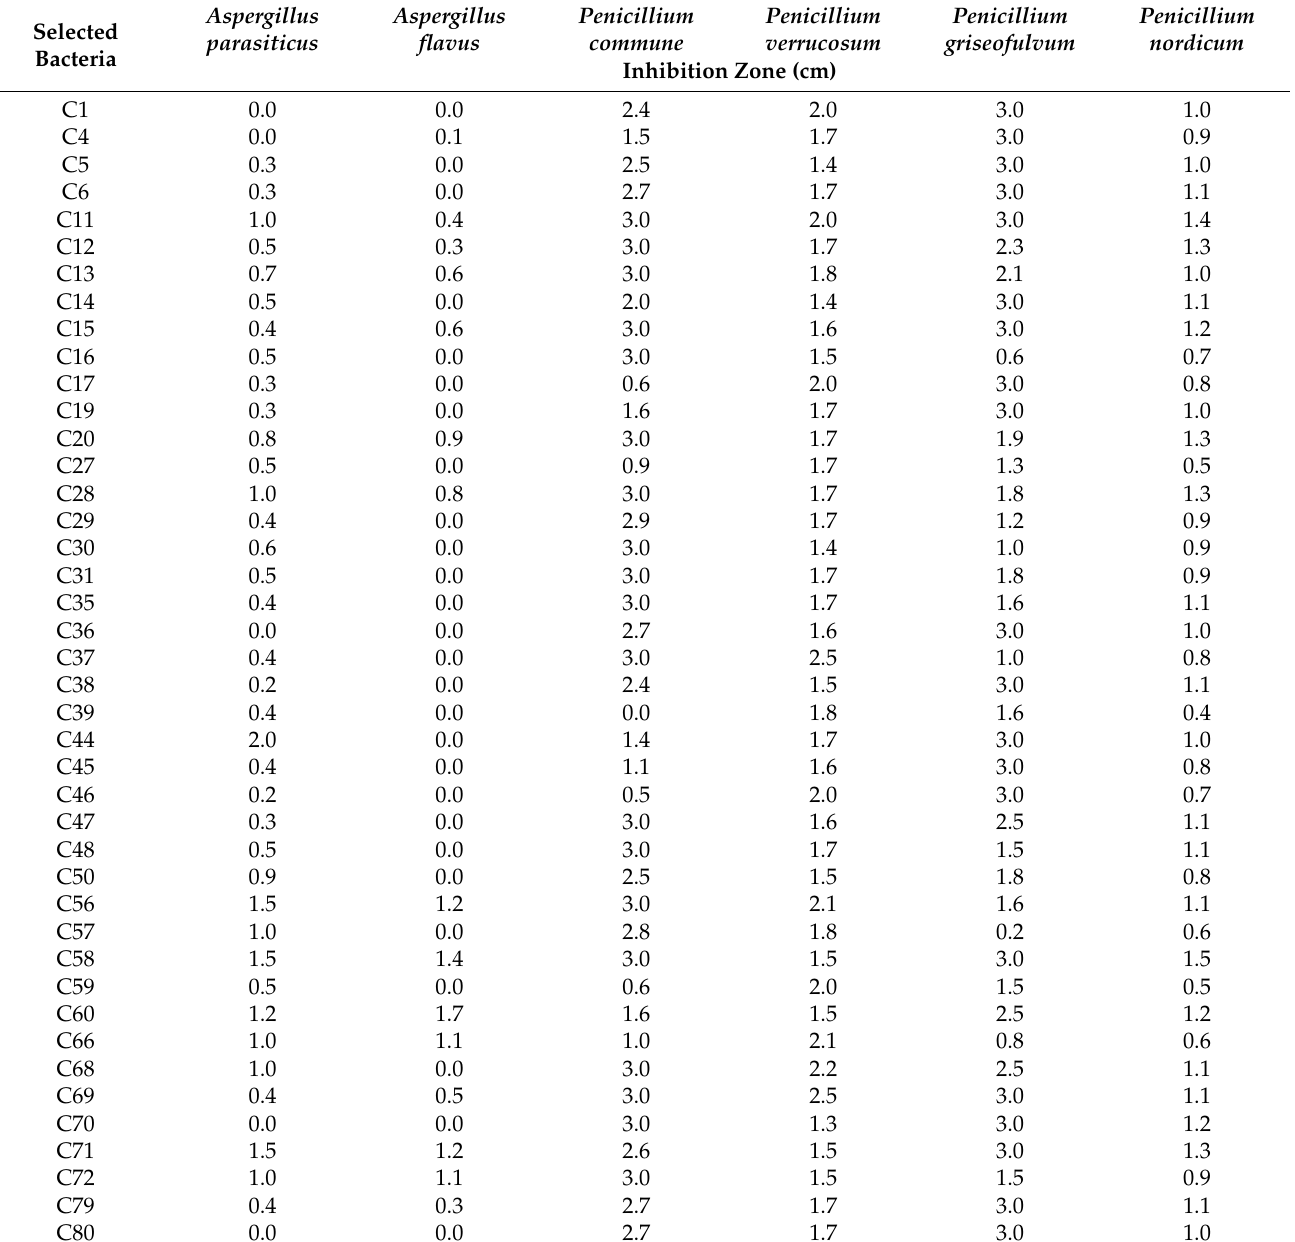
Table 2. Antifungal activity of LAB by overlay